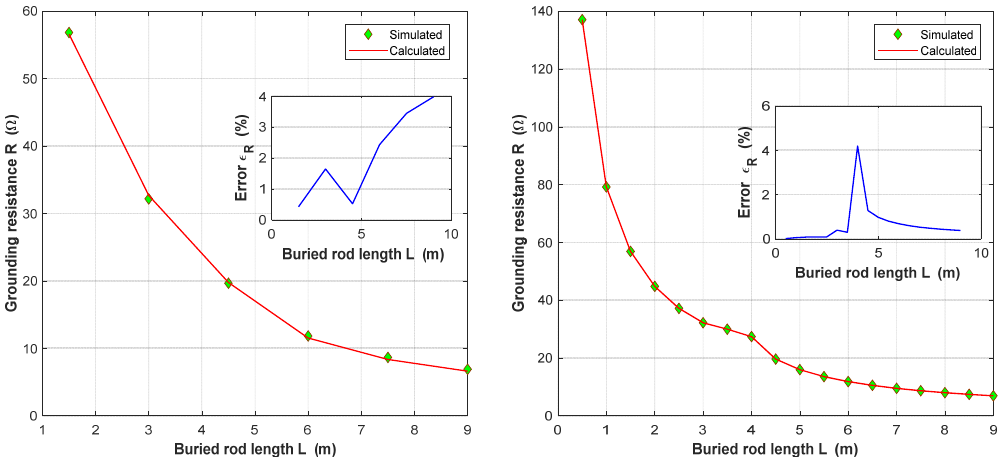
Figure 7. Grounding resistance vs buried length of a rod composed by sections of 0.5 m length ( left panel) and 1.5 m length ( right panel) joined by resistive segments.